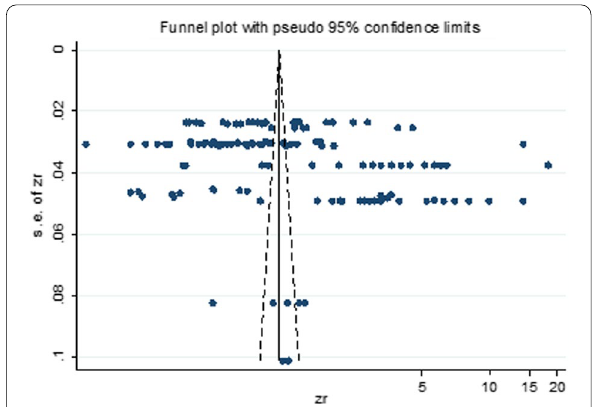
Fig. 2 Funnel plot. Note SE denotes standard